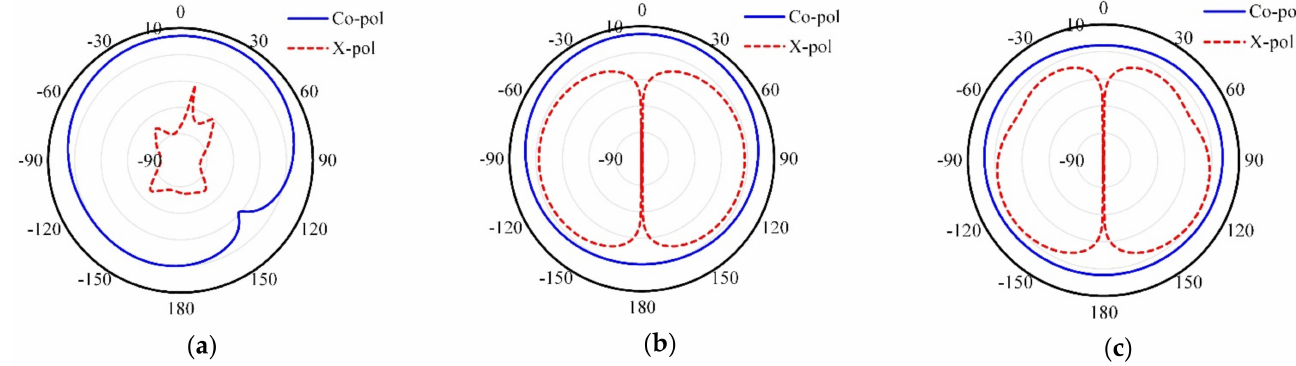
Figure 13. Co-polarized and cross-polarized radiation patterns of the proposed antenna ( a ) xz-plane, ( b ) yz-plane, and ( c ) xy-plane.